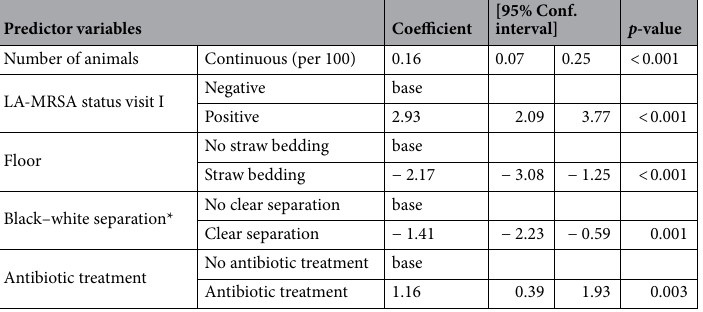
Table 2. Results of the logistic regression model analyzing the influence of predictor variables on LA-MRSA status at visit II (end of fattening period). *= separation of the paths of pig husbandry and non-pig